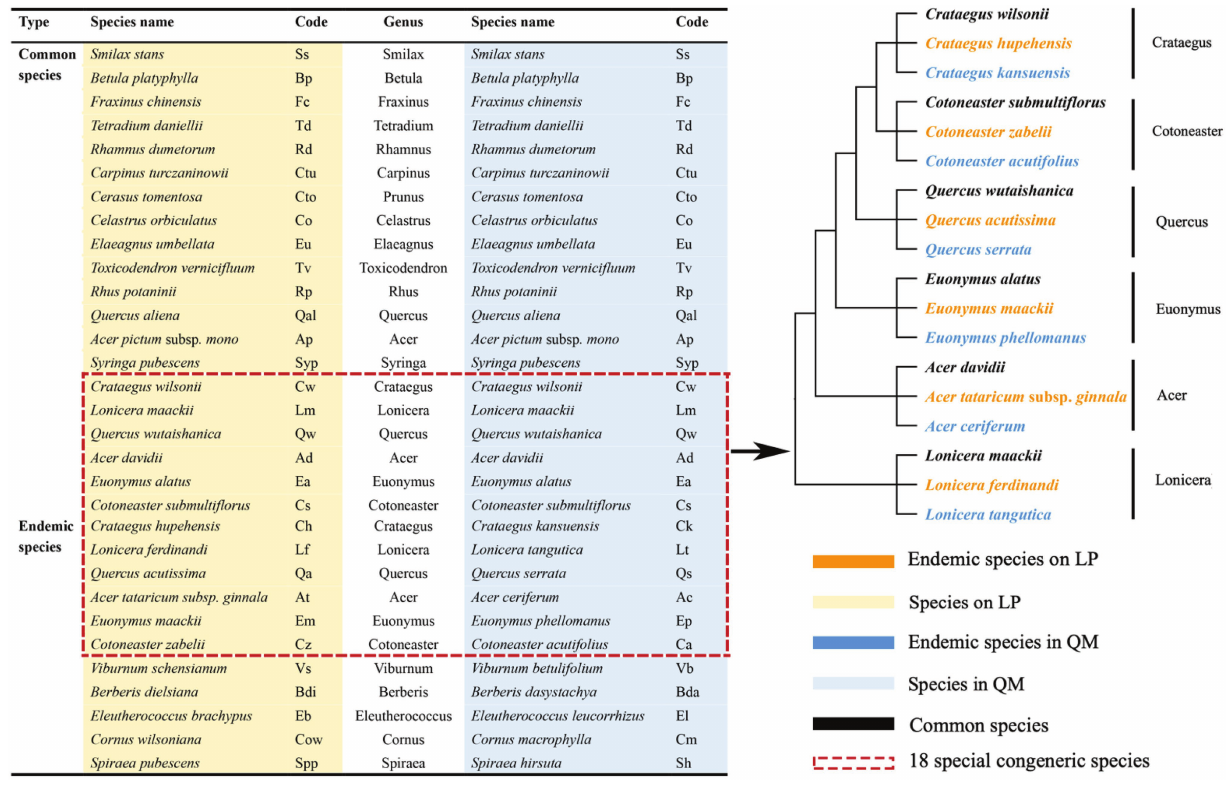
FIGURE 1 | List of 31 pairs of congeneric species (including 20 pairs of congeneric common species and 11 pairs of congeneric endemic species) in Quercus wutaishanica forests across two regions and evolutionary relationship for 18 special congeneric species in six genera selected for this study.